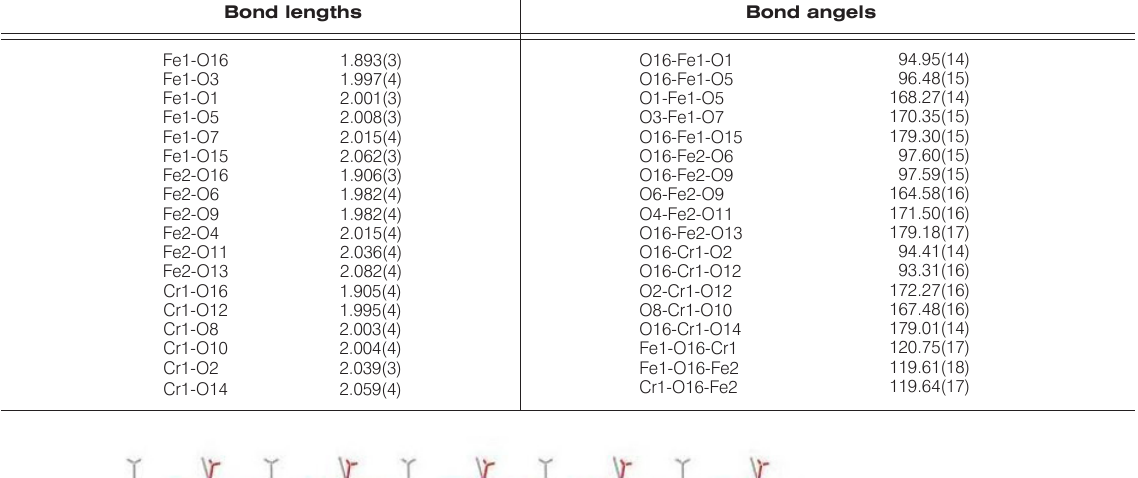
Table 3. Selected Bond lengths [Å] and angles [ ° ] for title compound.